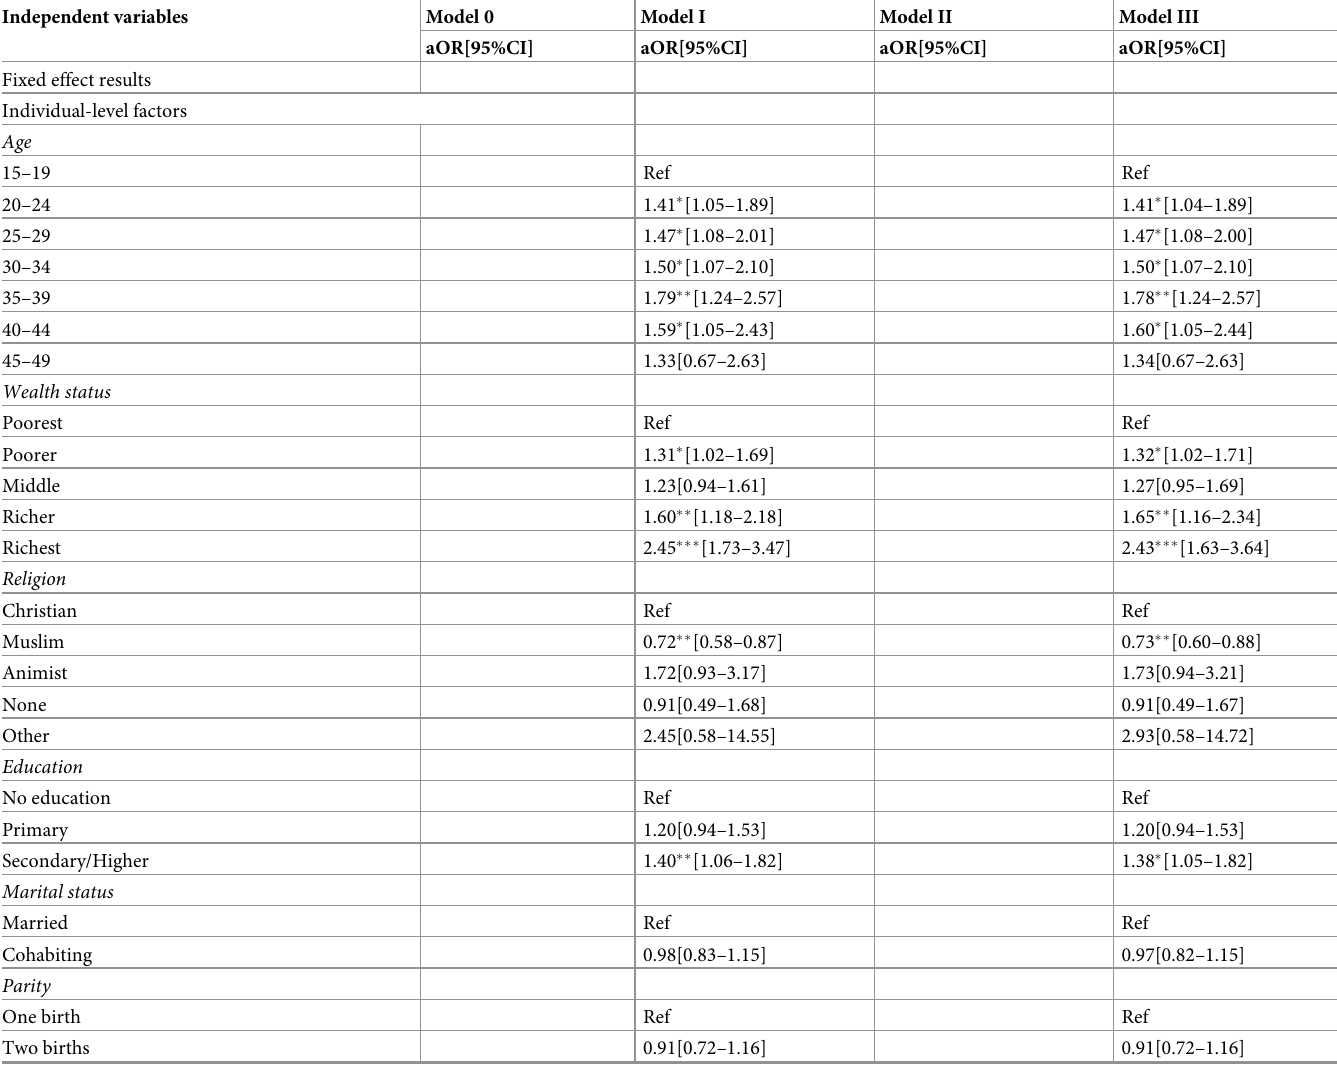
Fixed effect results. The third model (Model III) in Table 2 shows the fixed effect results of individual and community-level factors on early ANC. Compared with women aged 15–19, Table 2. A mixed effect of individual and community-level factors on early initiation of antenatal care. Independent